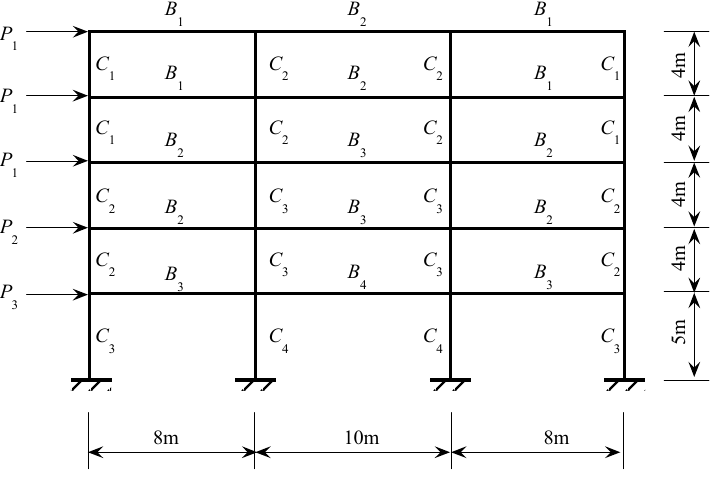
Figure 5. Three-bay five-story frame structure considered in Example 3.